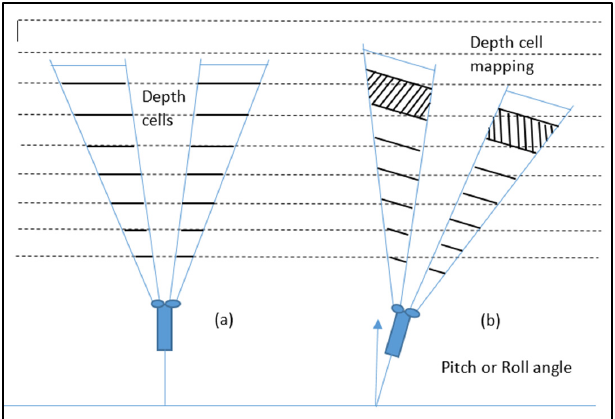
Figure 2. Acoustic Doppler profiler (ADP) tilt and bin mapping ( a ) without tilt; ( b ) Processing bin mapping with the presence of tilt.